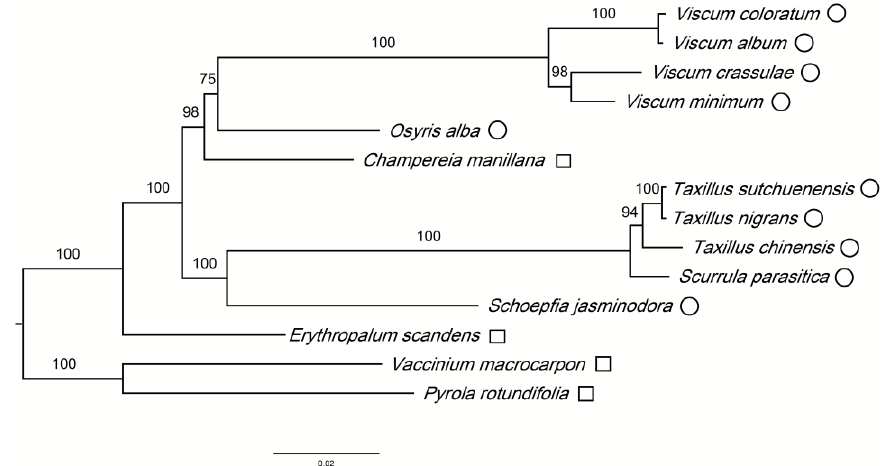
Figure 5. Maximum likelihood phylogenetic tree of Santalales based on 39 protein-coding genes. (Hemiparasitic plants are labeled with circles ( ○ ), and autotrophic plants are marked with white squares (□)).